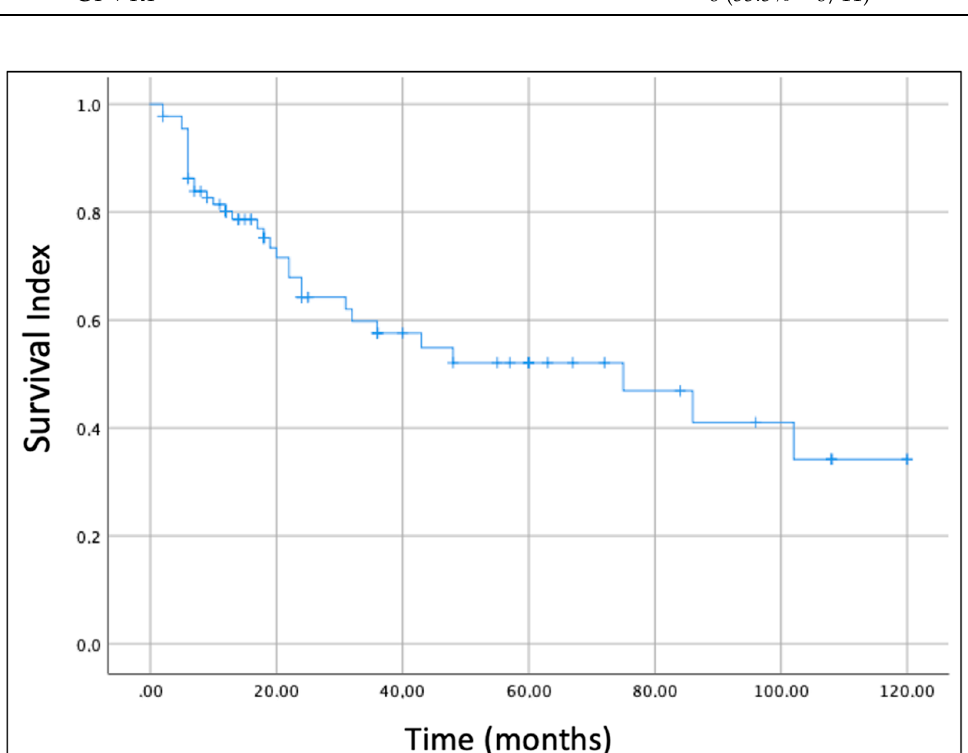
Figure 2. Kaplan-Meier curve and global overall survival (OS) of the patients with parotid gland sarcoma included in this study.